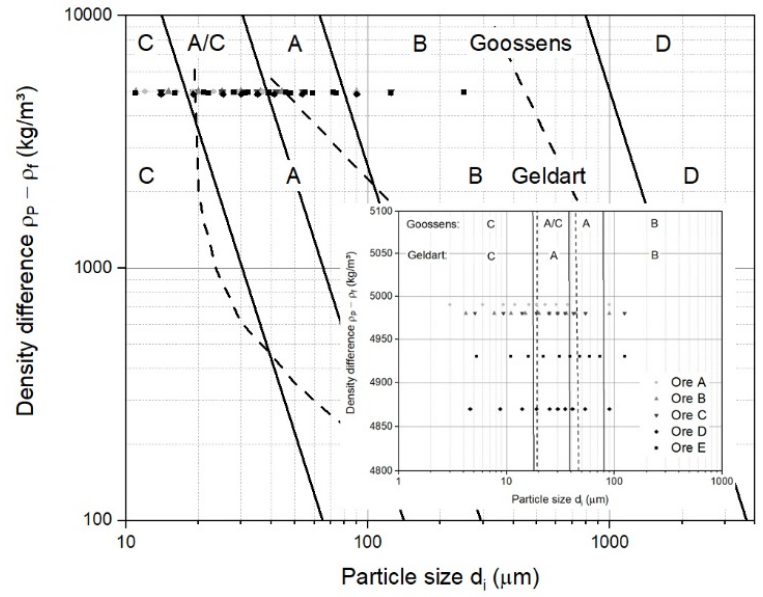
Figure 3. General classification diagram for fluidized particles under ambient conditions and air, including boundaries based on Geldart [40], dashed lines, and Goossens [41], solid lines, data of iron ore ultra-fines, and a detailed section.